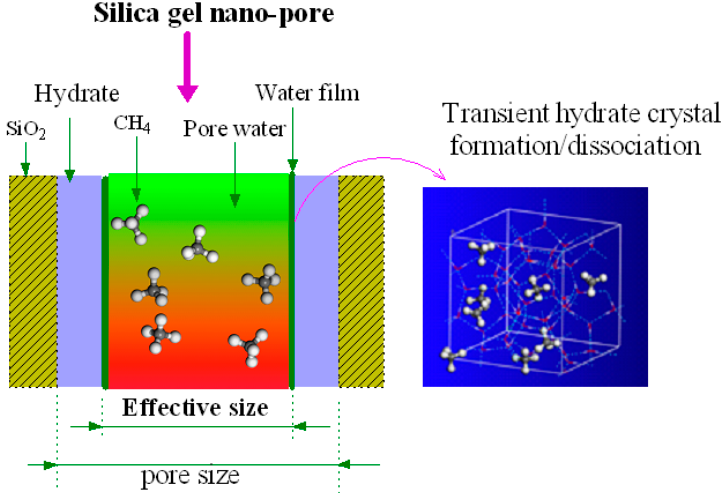
Figure 10. Schematic representation of the methane hydrate formation/dissociation process in nano-silica gel pores.